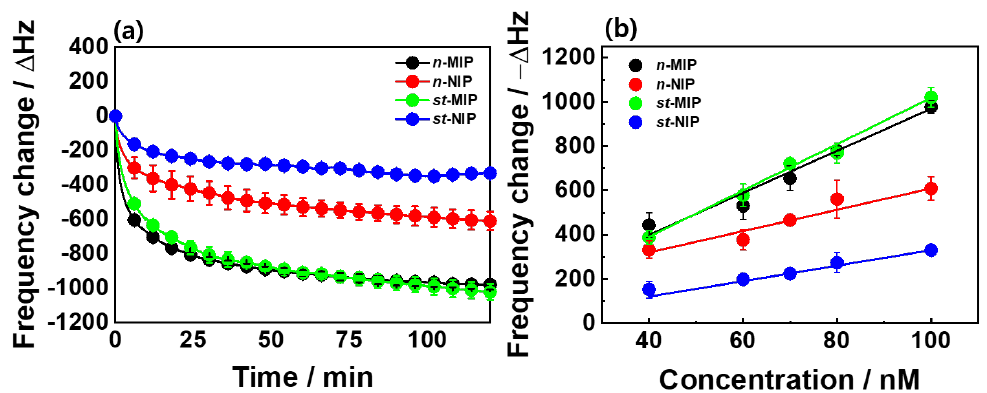
Figure 4. ( a ) Frequency change ( ∆ f ) on the n -MIP/NIP and st -MIP/NIP films as a function of time in a 100-nM 2,4-D aqueous solution for a 2-h rebinding process and ( b ) frequency change ( ∆ f ) as a function of 2,4-D’s concentration (from 40 to 100 nM).